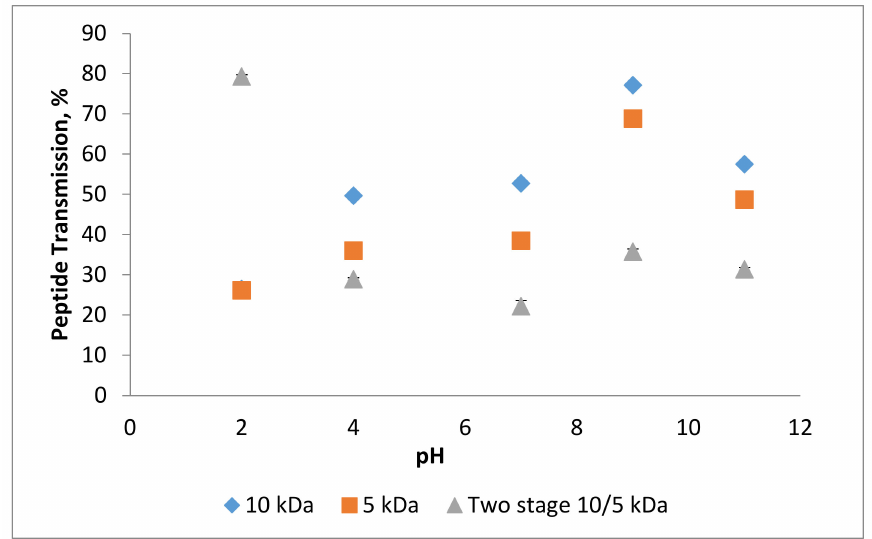
Figure 10. Peptide transmission at different pH for single and two stage UF membranes.